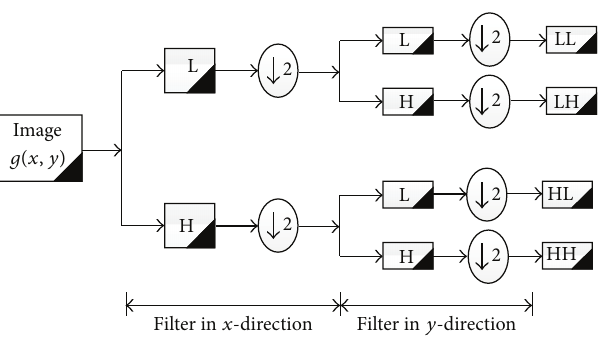
Figure 3: Decomposition algorithm of 2D wavelet transform [12].